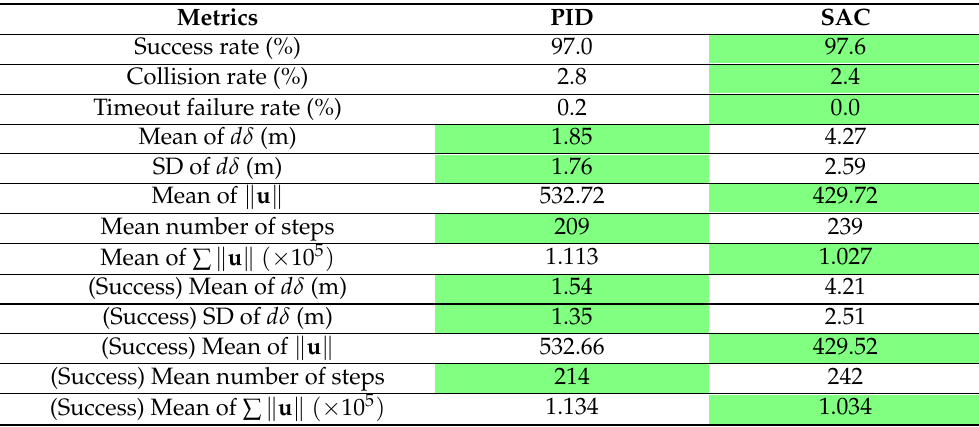
Table 4. Testing phase of a model after removing the position vector, the Euler angles, and the pitch error from the state vector, trained on 600 episodes. For each metric, the controller with the best score is highlighted in green.